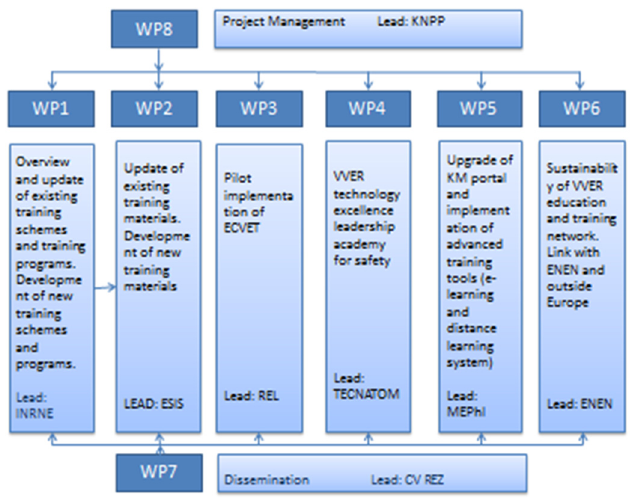
Fig. 8. Functional sketch of the CORONA-II